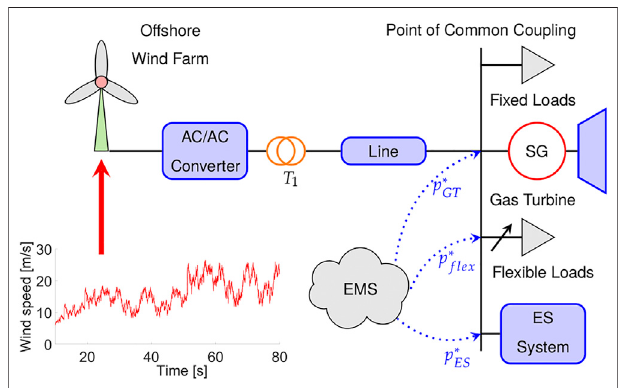
FIGURE 5 | Schematic representation of the case study ACPS.